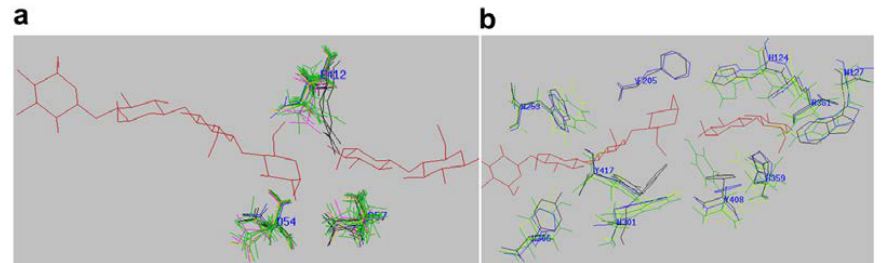
Figure 4. Active-site pocket of selected GH9 cellulases showing conserved residues around the substrate superimposed on each other. ( a ) Catalytic-residues (above, E412; below left to right, D54, D57) and ( b ) binding-residues (above from left to right: W253, F205, H124, R361, W127; below from left to right: H306, Y417, W301, Y408, H359). The residue number refers to that of termite (PDB, 1KS8). Red, substrate (C4 + C2); blue, termite; green, algae; pink, spinach; black, T. fusca (4TF4); orange, fungus ( Neocallimastix patriciarum ).